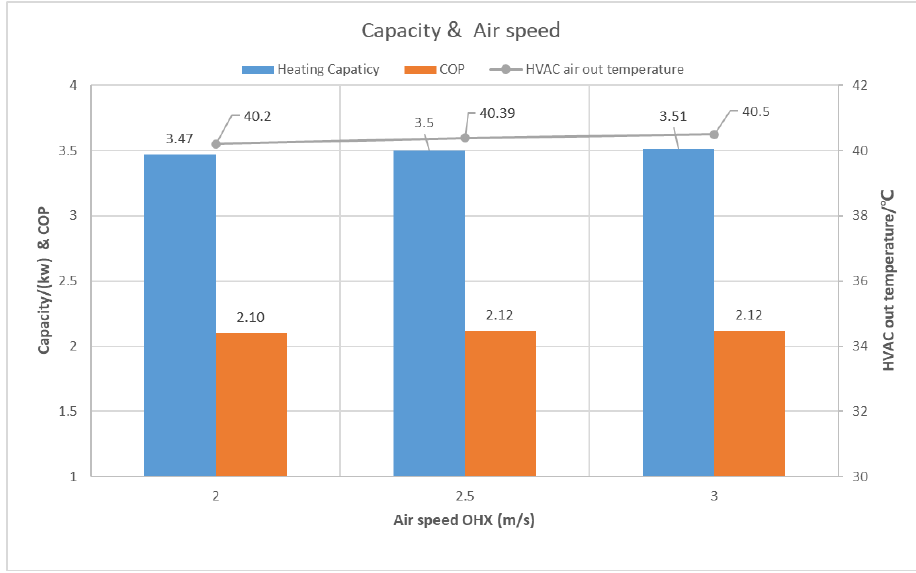
Figure 9. COP along with discharge pressures in different HVAC air flows.